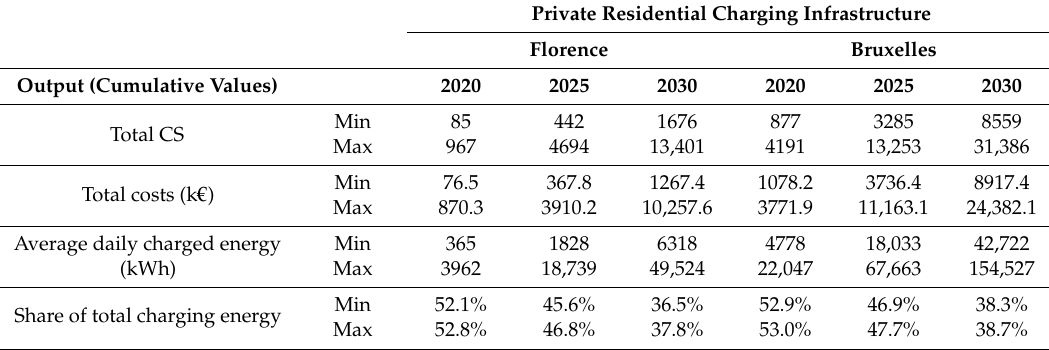
Table 14. Model results for xEV fleet forecast and private residential charging infrastructure for Florence and Bruxelles area.